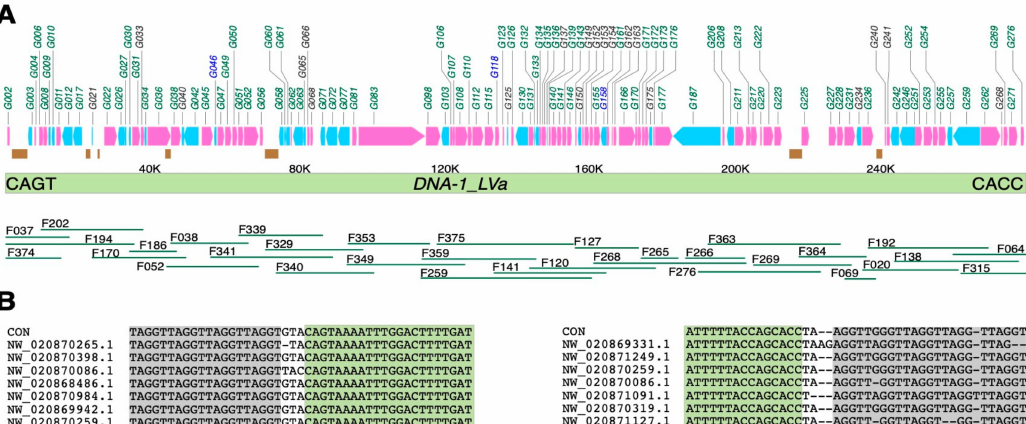
Figure 1. ( A ) Schematic representation of Nimav-1_LVa endogenous nimavirus and the encoded genes. Uppermost part indicates the location of genes and their transcription orientation (in pink or light blue). Gene names in black are 20 hypothetical genes, gene names in blue ( n = 3) indicate no viral homologs are found, genes in green ( n = 94) indicate viral homologs are found. The brown boxes indicate the locations of long tracts of simple tandem repeats. Solid lines below the Nimav-1_LVa bar represent some larger Nimav-1_LVa segments present in the Kehai No. 1 assembly. The accession number and location of the segments can be found in Supplementary Table S1; ( B ) Sequence alignment of the terminal regions of the linear Nimav-1_LVa and the flanking sequences. The green-shaded regions belong to Nimav-1_LVa . The telomeric (TAACC / GGTTA) n microsatellite regions are shaded in